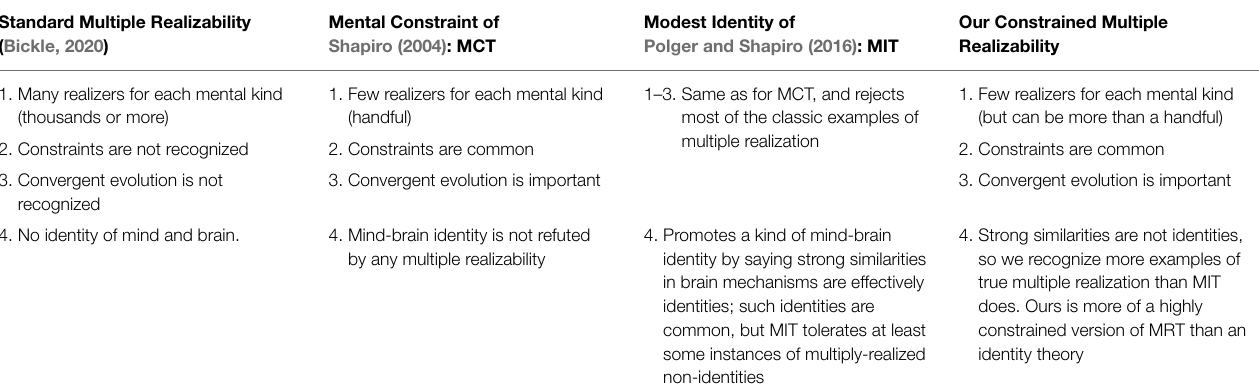
TABLE 3 | Comparison of the theories presented in this paper, on the realizability of mental states in different